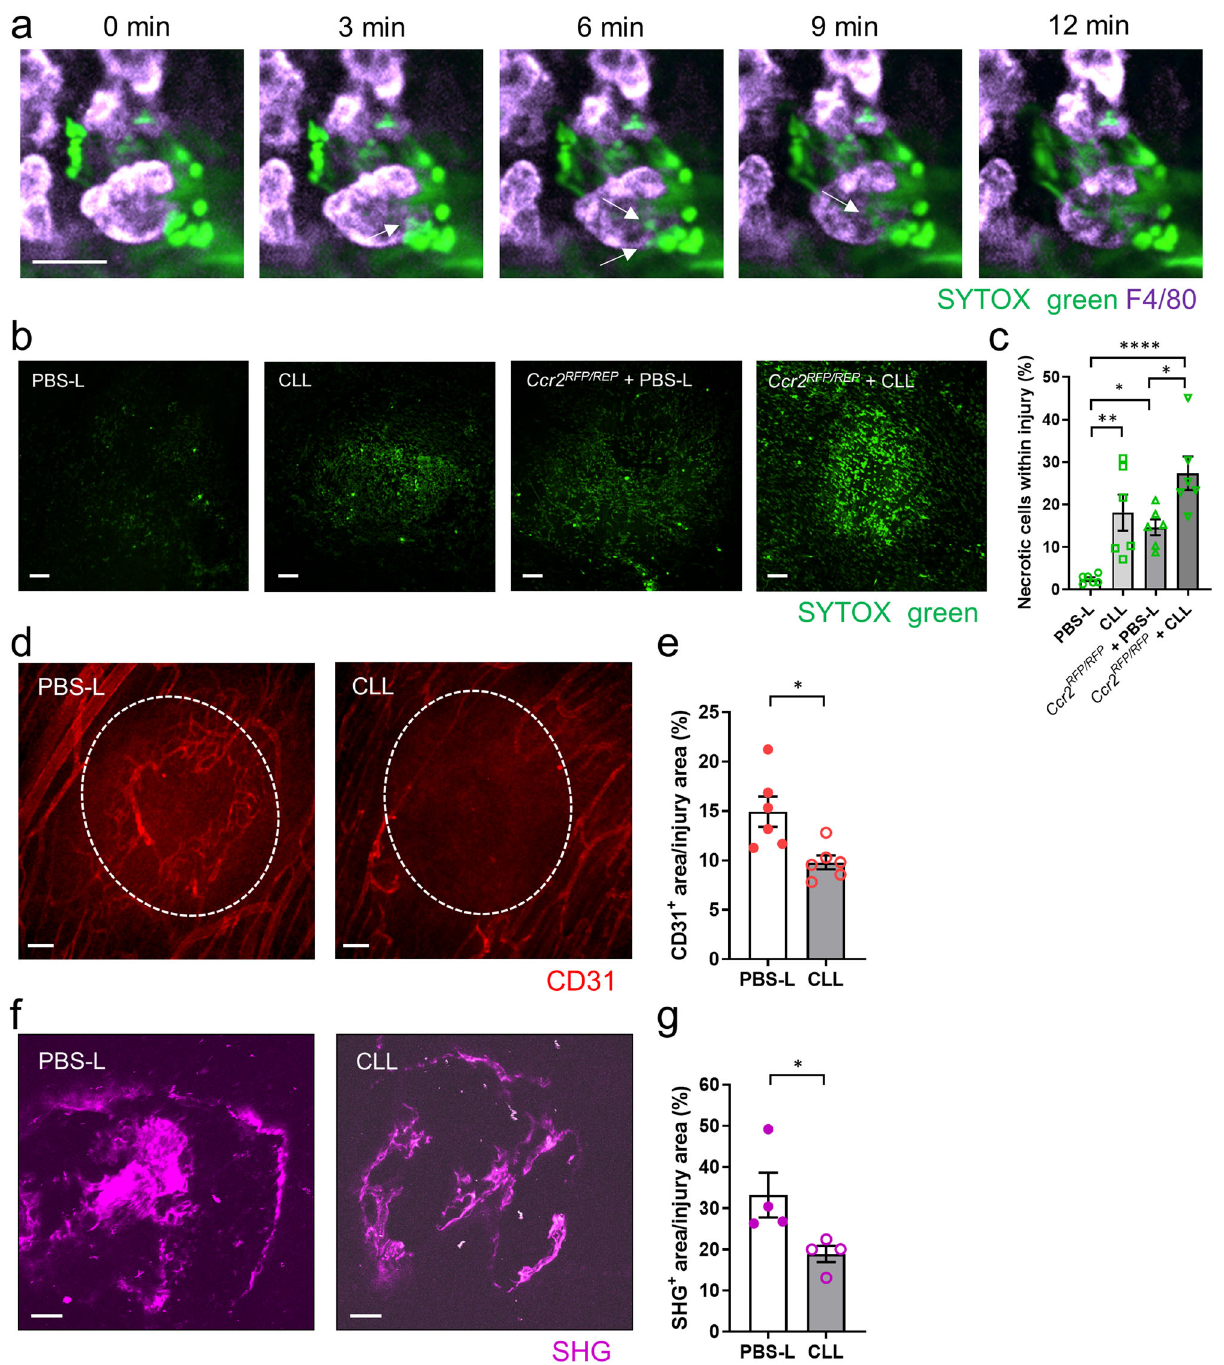
Fig. 5 Peritoneal cavity macrophages facilitate intestinal repair. a Time-lapse images showing F4/80 hi large macrophage pulling off SYTOX green + particles within the intestinal injury site. Elapsed time is shown. Scale bar, 20 μ m. b Representative images of SYTOX green + cells within intestinal injury site at 48 h post-injury in PBS-L- or CLL-treated CCR2 + / + and CCR2 RFP/RFP mice. Scale bars, 100 μ m. c Quanti fi cation of SYTOX green + area within injury in each group. n = 6/group. d Representative images of intestinal injury site 48 h after injury in PBS-L- or CLL-treated mice. Mice were administered an anti- CD31 (red) antibody intravenously to visualize vasculature. The white dashed line highlights the original injury border. Scale bars, 100 μ m. e Quanti fi cation of revascularization (CD31 + area within injury). n = 6/group. f Representative images of collagen (purple) within intestinal injury site 72 h post-injury in PBS-L- or CLL-treated mice. Scale bars, 50 μ m. g Quanti fi cation of collagen deposition. n = 4/group. Data represent mean ± SEM. * p < 0.05, ** p < 0.01, **** p < 0.0001. P values were calculated with two-tailed unpaired Student t -test ( e , g ) and one-way ANOVA followed by Tukey ’ s post hoc test ( c ). Source data are provided as a Source Data fi